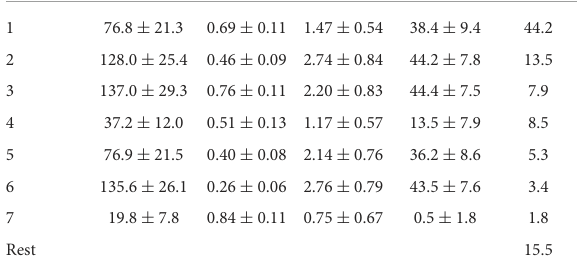
TABLE 1 Motility characteristics of the different sperm